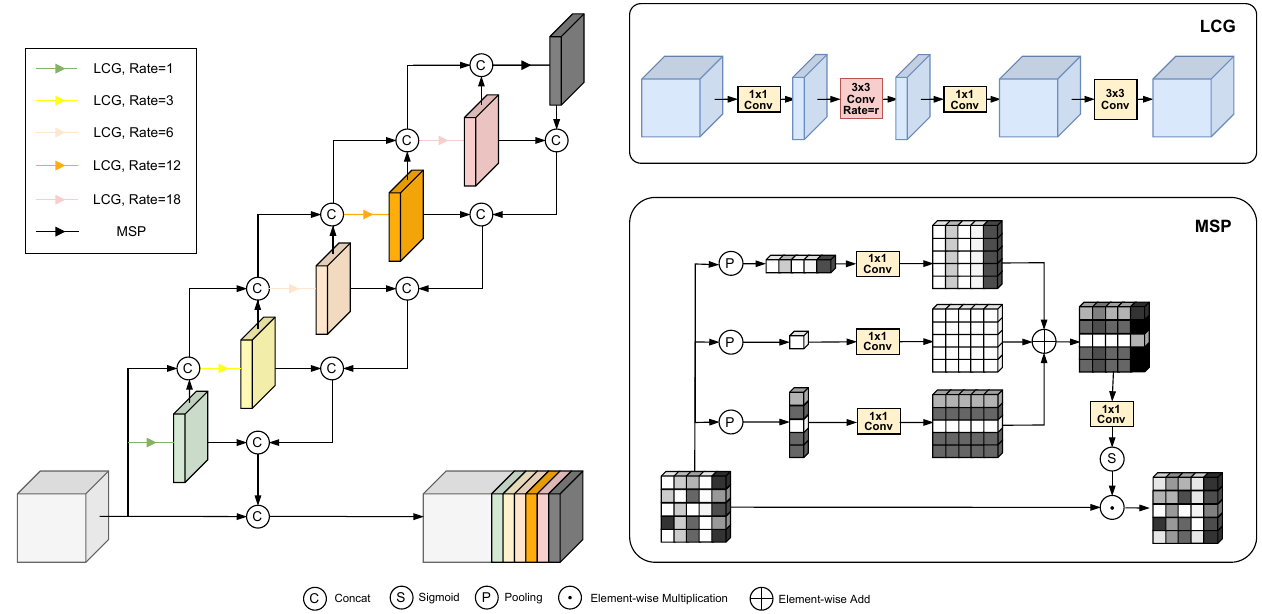
Figure 4. The architecture of cross-scale semantic aggregation module.